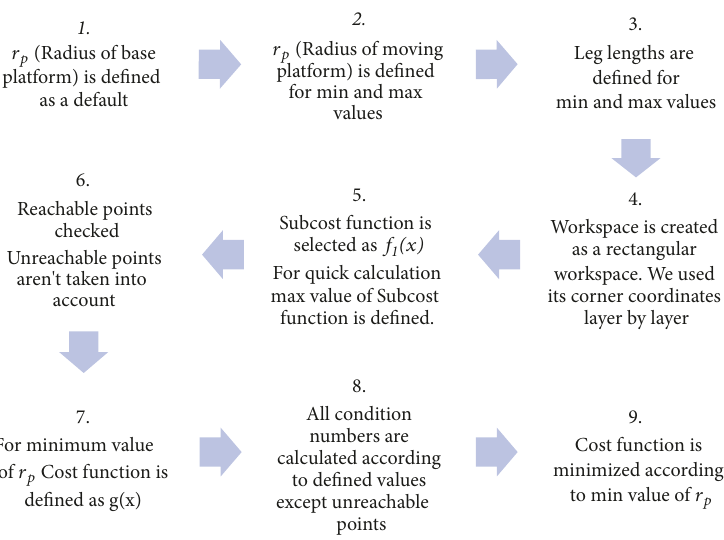
Figure 3: Algorithm for one-variable